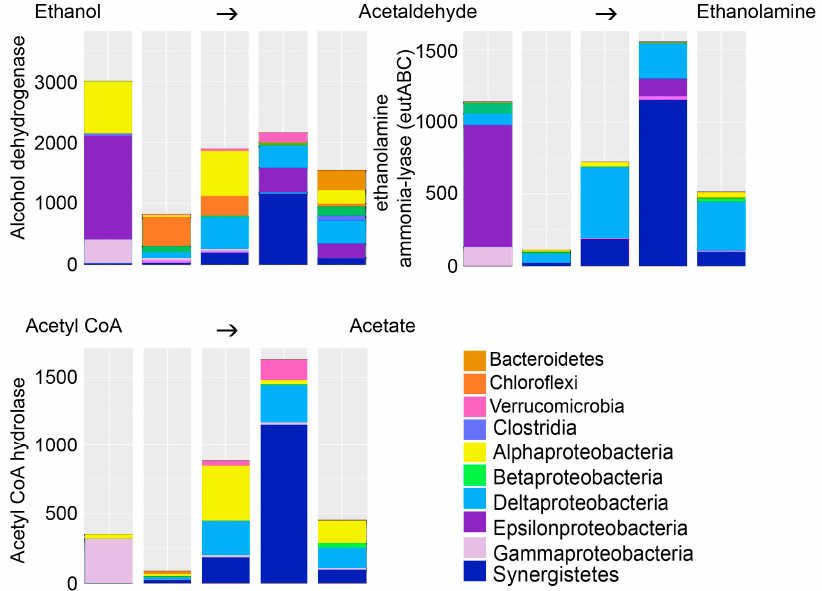
Figure 7. The bacterial groups able to oxidize ethanol into acetaldehyde and further into ethanolamine, which serves as precursor for the synthesis of amino and fatty acids. Acetate is produced through fermentation by oxidation of pyruvate to acetate via Acetyl CoA. The Y -axis shows the number of sequence reads. The taxonomic groups are shown by the color charts in each figure. The columns in each chart from the left; BR1 day 101, BR1 day 140, BR2 day 101, BR3 day 101, BR3 day 140.